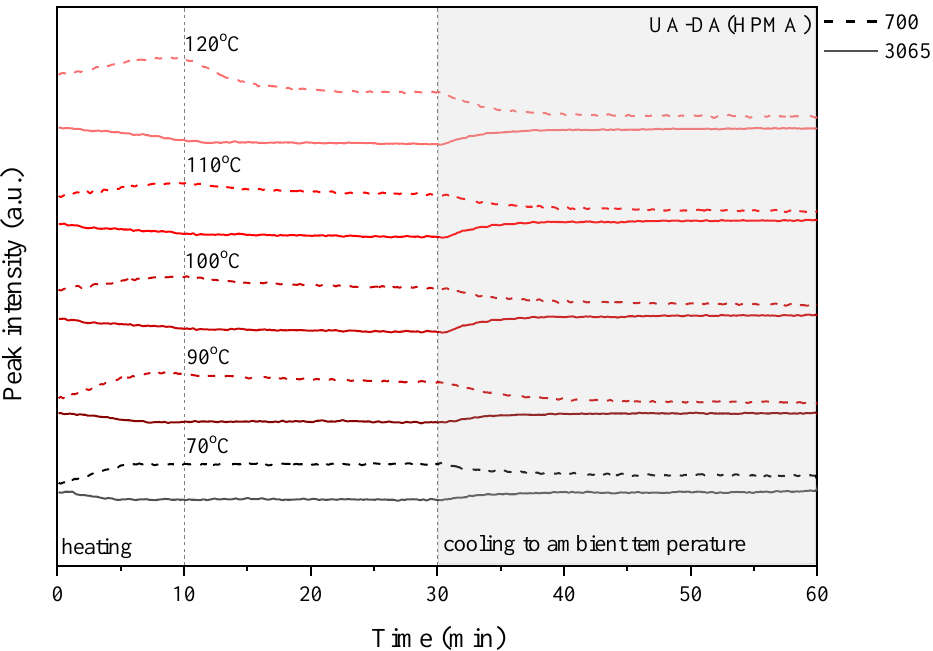
Figure 13. Change in the relative height of selected peaks based on the three-dimensional FTIR spectrum observed during the heating – thermostat – cooling cycle for the UV-cured UA-DA(HPMA) sample.